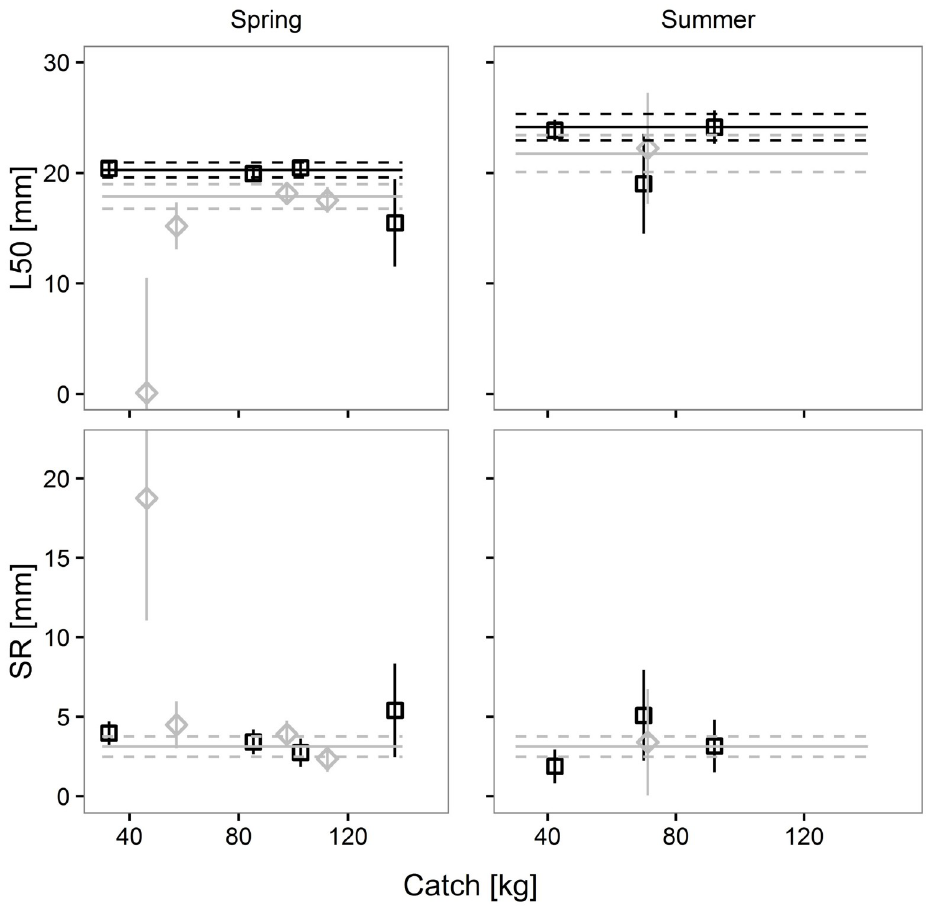
Fig 6. Prediction of Norway lobster size selectivity parameters, L50 and SR, versus codend catch weight. Black solid and dashed lines represent the predicted mean values and 95% CI for the SM40 codend. Grey solid and dashed lines represent the predicted mean values and 95% CI for the DM50 codend. Squares and diamonds represent the results of individual hauls and their 95% CI for the SM40 and the DM50 codend, respectively. The Black solid and dashed lines for SR are masked by the grey solid and dashed